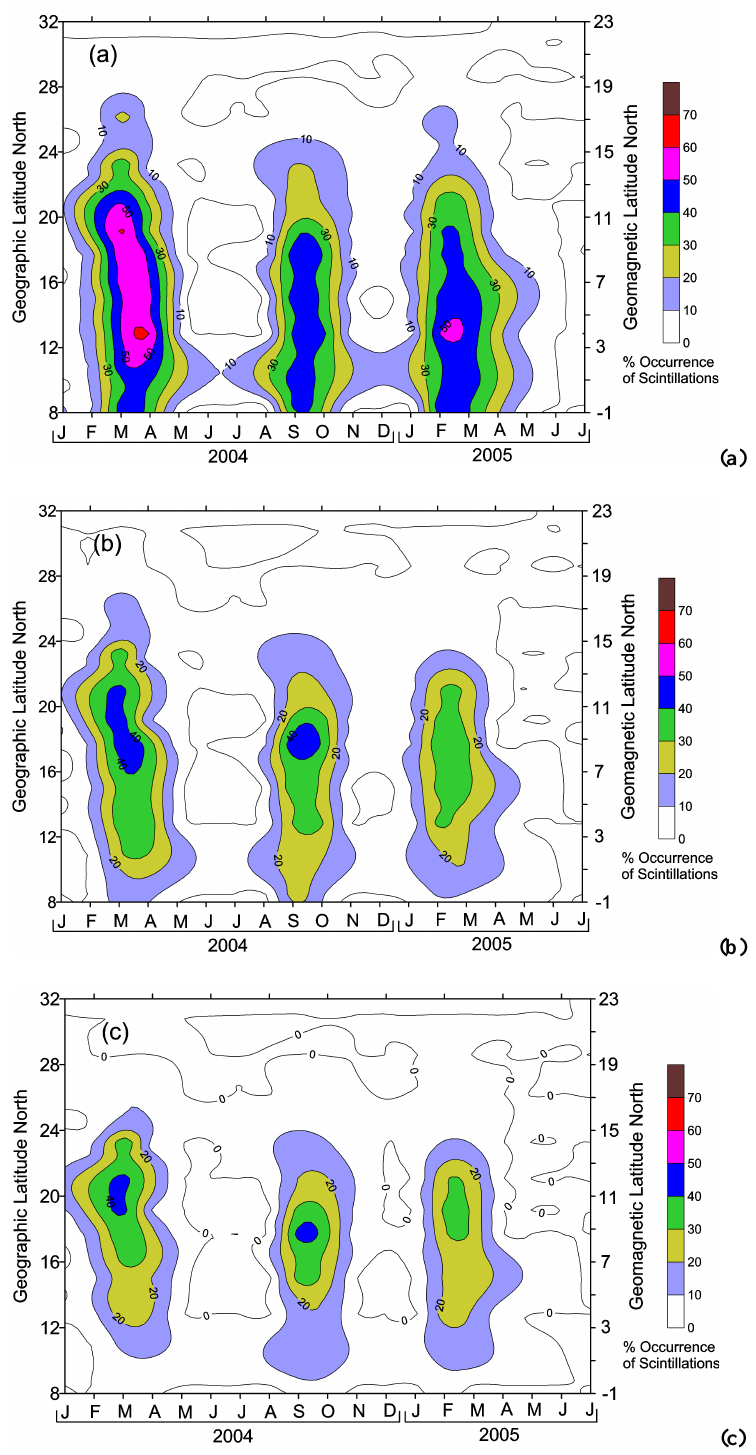
Fig. 4. Temporal and spatial variations in the occurrence of scintillations during the low sunspot activity years of 2004 and 2005 at different power levels of (a) > 3dB, (b) > 6dB, (c) >